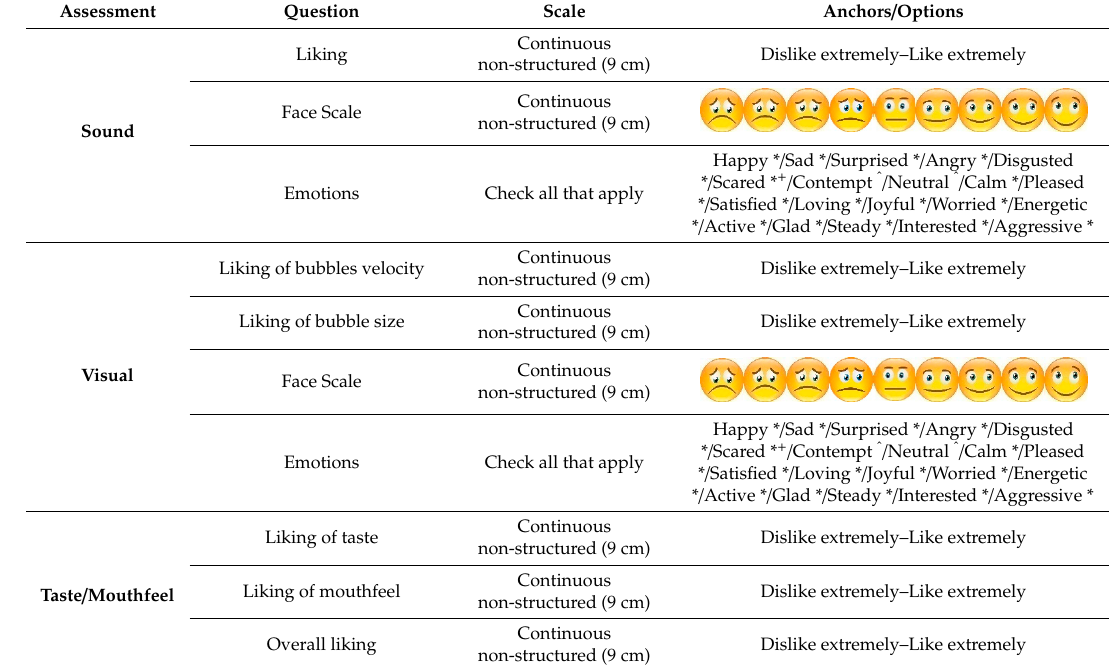
Table 2. Questionnaire presented to consumers in the sensory session for each sample.